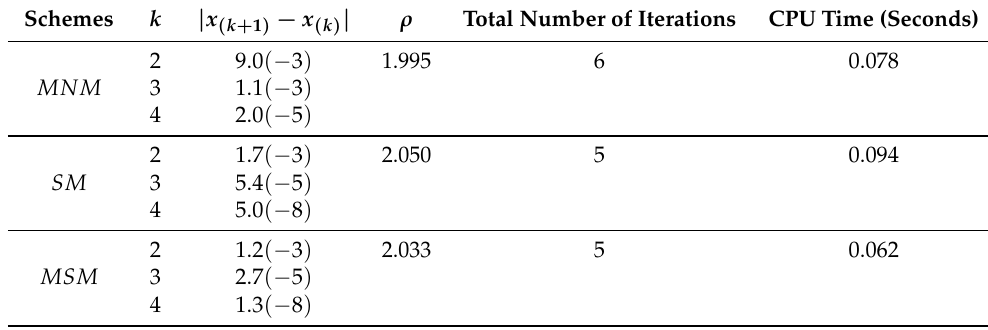
Table 4. Convergence behavior of the methods MNM , SM , and MSM at approximation x 0 =